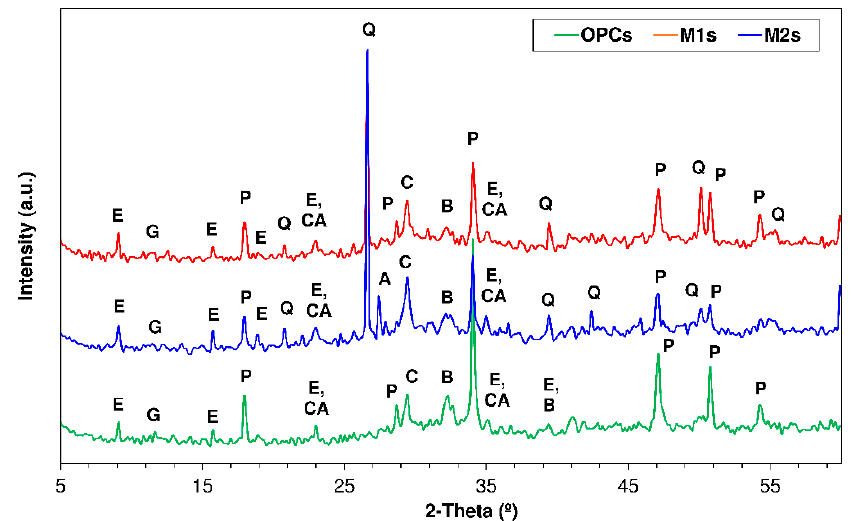
Figure 7. XRD patterns for 56 d OPC, M1 and M 2 exposed to 0.3 M Na 2 SO 4 (Note—E: ettringite; G: gypsum; CA: calcium monocarboaluminato; P: portlandite; Q: quartz; O: orthoclase; A: Albite; C: calcite; and B: belite).